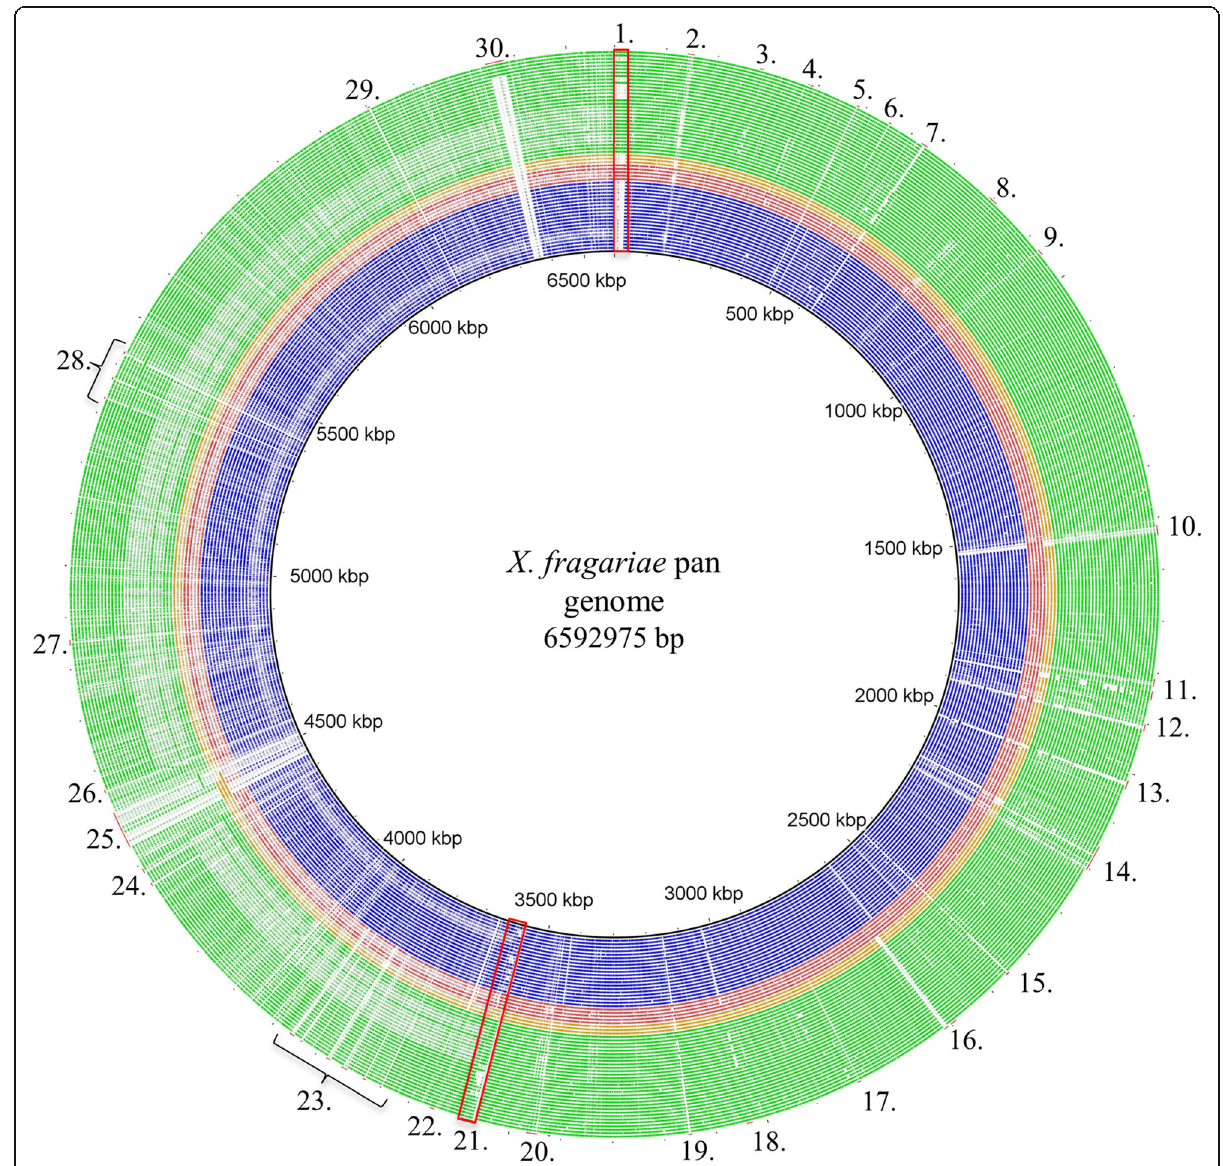
Fig. 2 Circular representation of non-linear pan genome from 58 Xanthomonas fragariae genomes used in this study. The complete genome of strain PD 885 T was used as reference. A total of 10,189 CDS were included in the pan genome and compared to all 58 strains. Each circle corresponds to a single X. fragariae strain. The colors used for the circles correspond to the X. fragariae CRISPR (sub) groups (Gétaz et al. 2018b); Xf -CGr-II: blue, Xf -CGr-IA: red, Xf -CGr-IB: orange, and Xf -CGr-IC: green. Strong colors correspond to a 100% identity, lighter colors correspond to 90% identity, and grey regions correspond to 70% identity. Numbers from 1 to 30 correspond to variable sites between assemblies. The sites 1 and 21 in the red squares correspond to the plasmid regions pXf29 and pXf21, respectively. The site 6 corresponds to CRISPR associated proteins Cas3, Csy1 and Csy2. Site 25 is composed of a phage-related cluster of proteins. Site 30 comprised a cluster of 10 VirB proteins, TrbM and hypothetical proteins and is present only in four strains ICMP 20572 to ICMP 20575. Finally, sites 2, 7, 8, 10, 14, 15, 17, 19, 20, 22, 26, 28 and 29 include mainly hypothetical